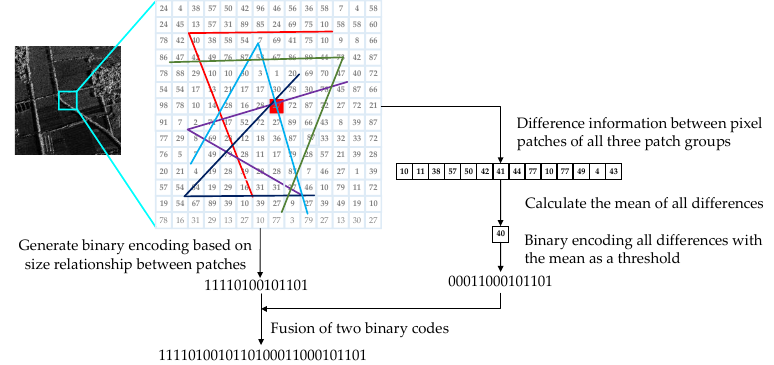
Figure 3. Feature fusion process proposed in this paper.